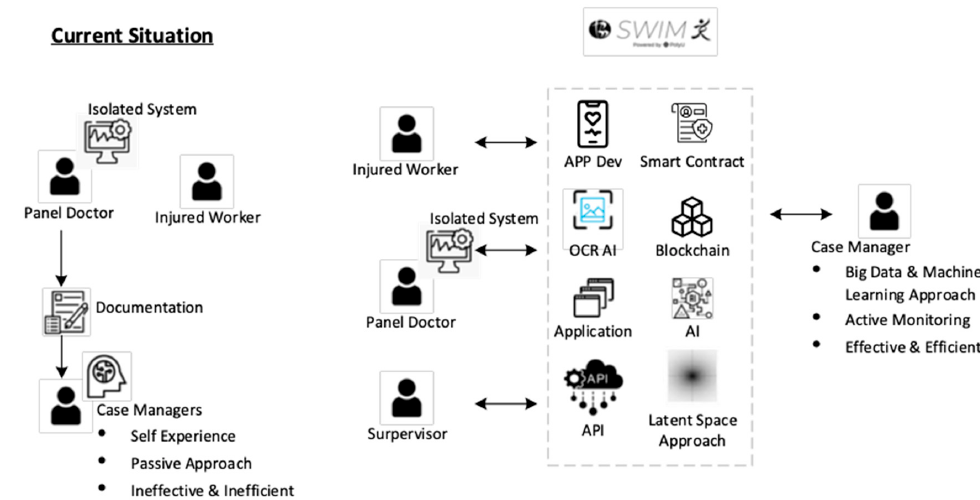
Figure 10. Overall concept of SWIM 2.0 development.